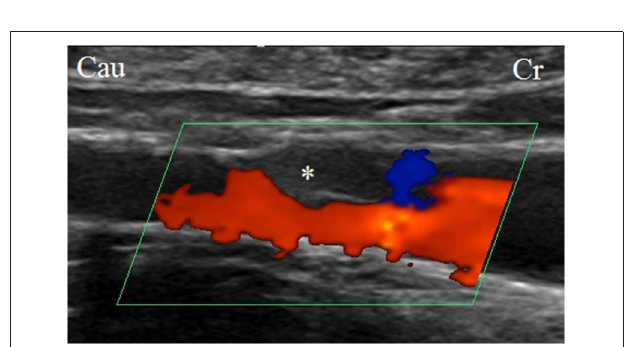
FIGURE 2 | Ultrasonographic image of the right external iliac artery with the test article (venous stent with polymeric inner valve—valve is indicated by asterix) positioned in situ . The blood flow was unidirectional.